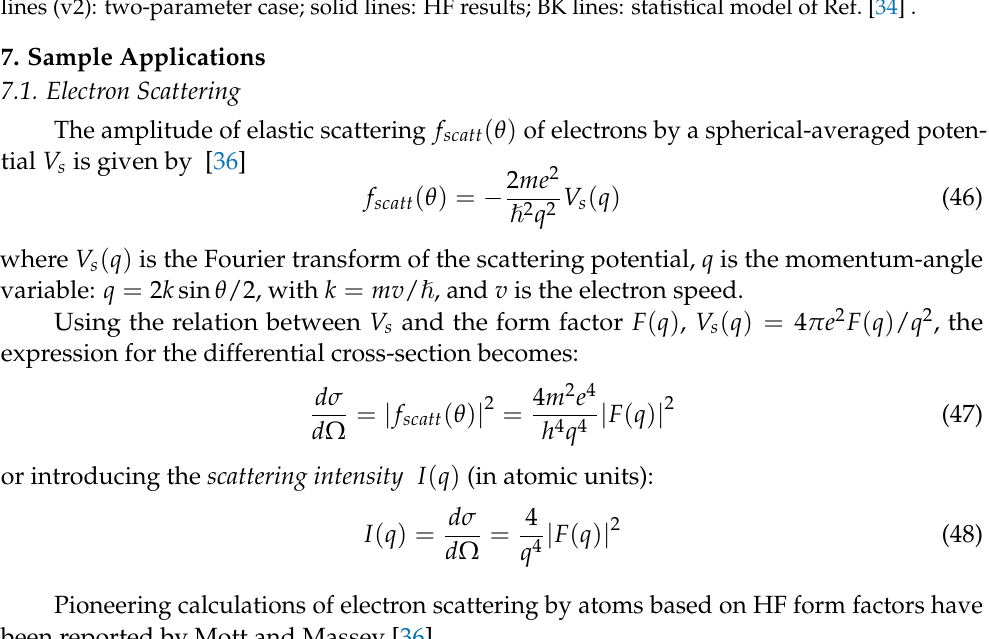
Figure 6. Form factors for Ne 0 , Ne 2 , Ne 4 + , and Ne 6 + . Dotted lines (v1): one-parameter case; dashed lines (v2): two-parameter case; solid lines: HF results; BK lines: statistical model of Ref. [34]